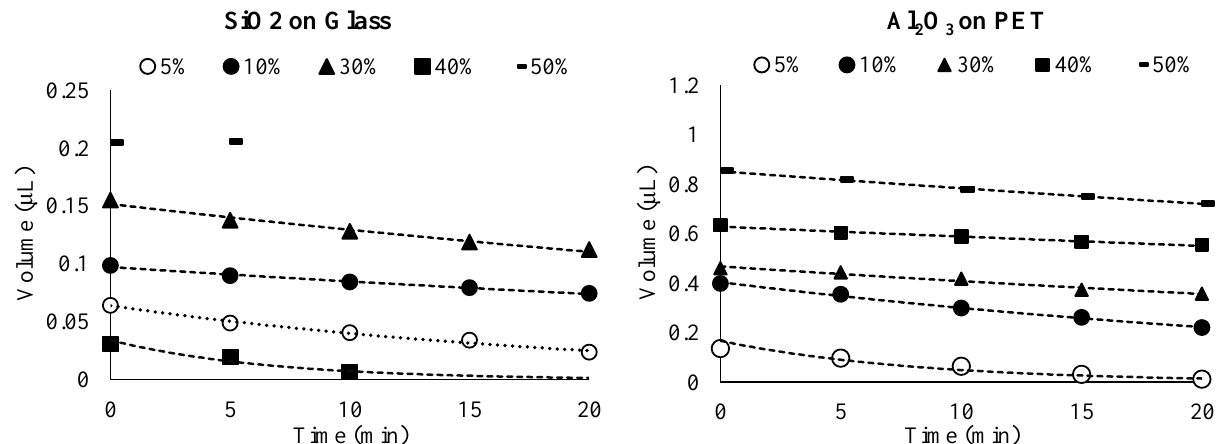
Figure 6—Volumes calculated by assuming that the profiles are given by segments of spheres, and plotted as functions of time. The curves represent exponential